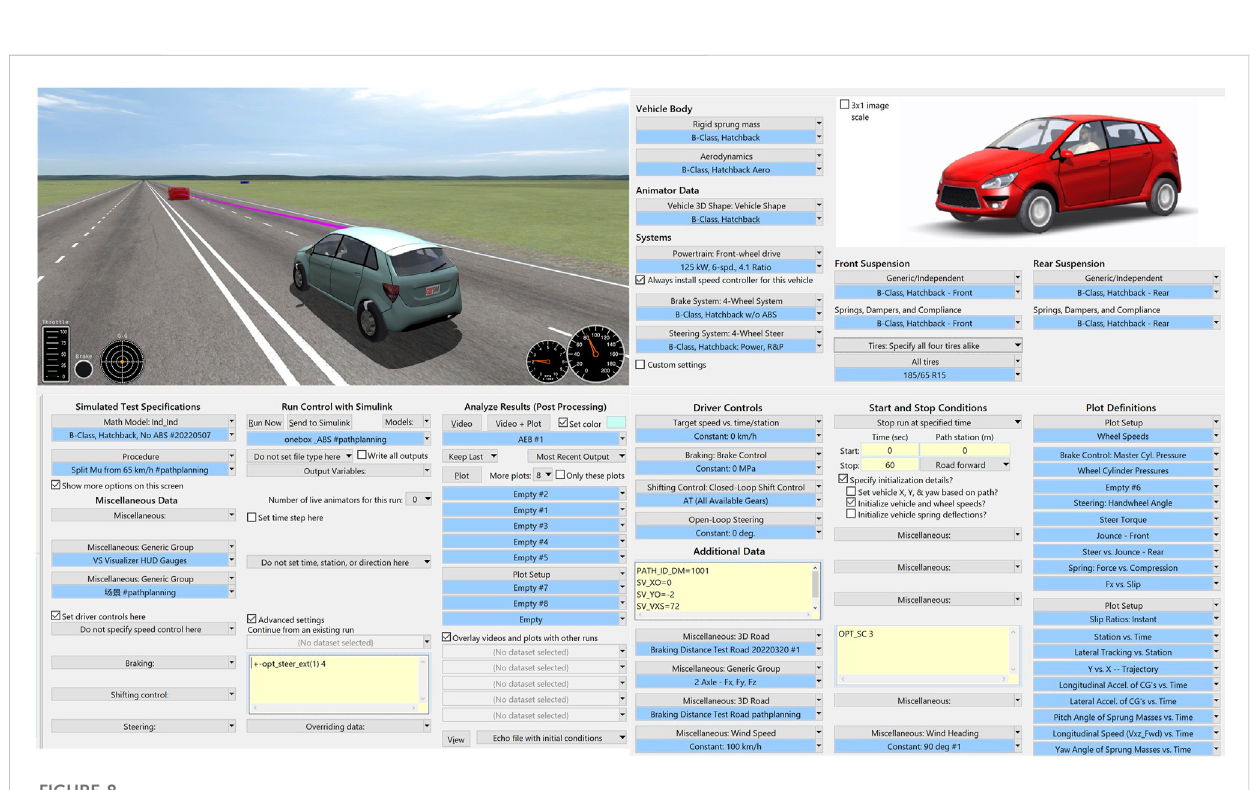
FIGURE 8 Carsim simulation